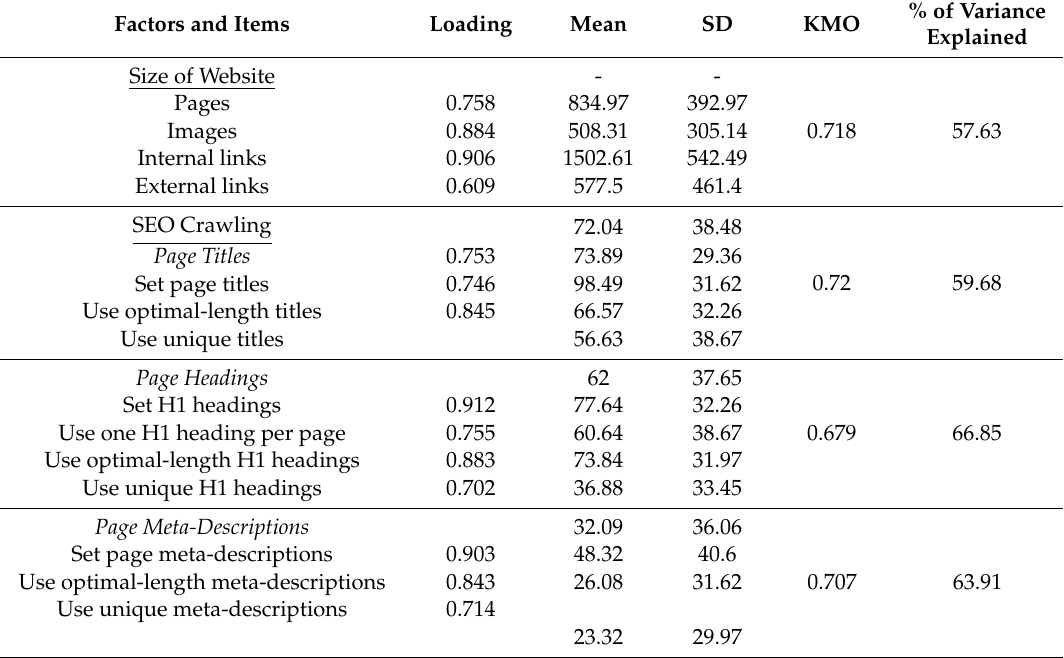
Table 2. Descriptives and internal validity and consistency of the examined factors and their